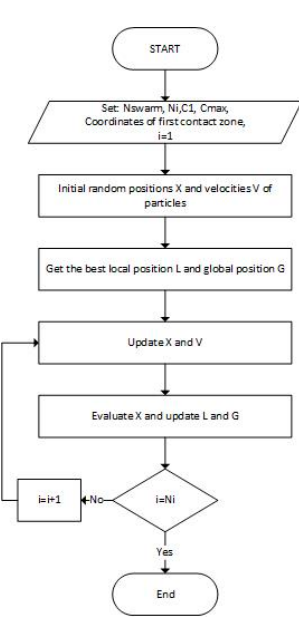
Figure 7. Flowchart of PSO.